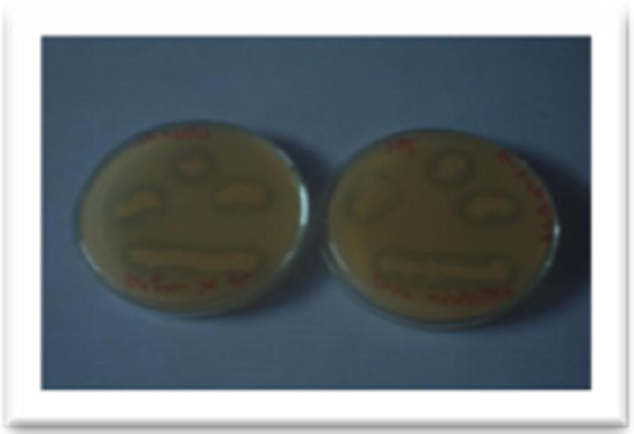
Fig(3) Inhibition zone of Bacillus subtilus against Aeromonas hydrophila after incubated Bacillus 3 ,4days